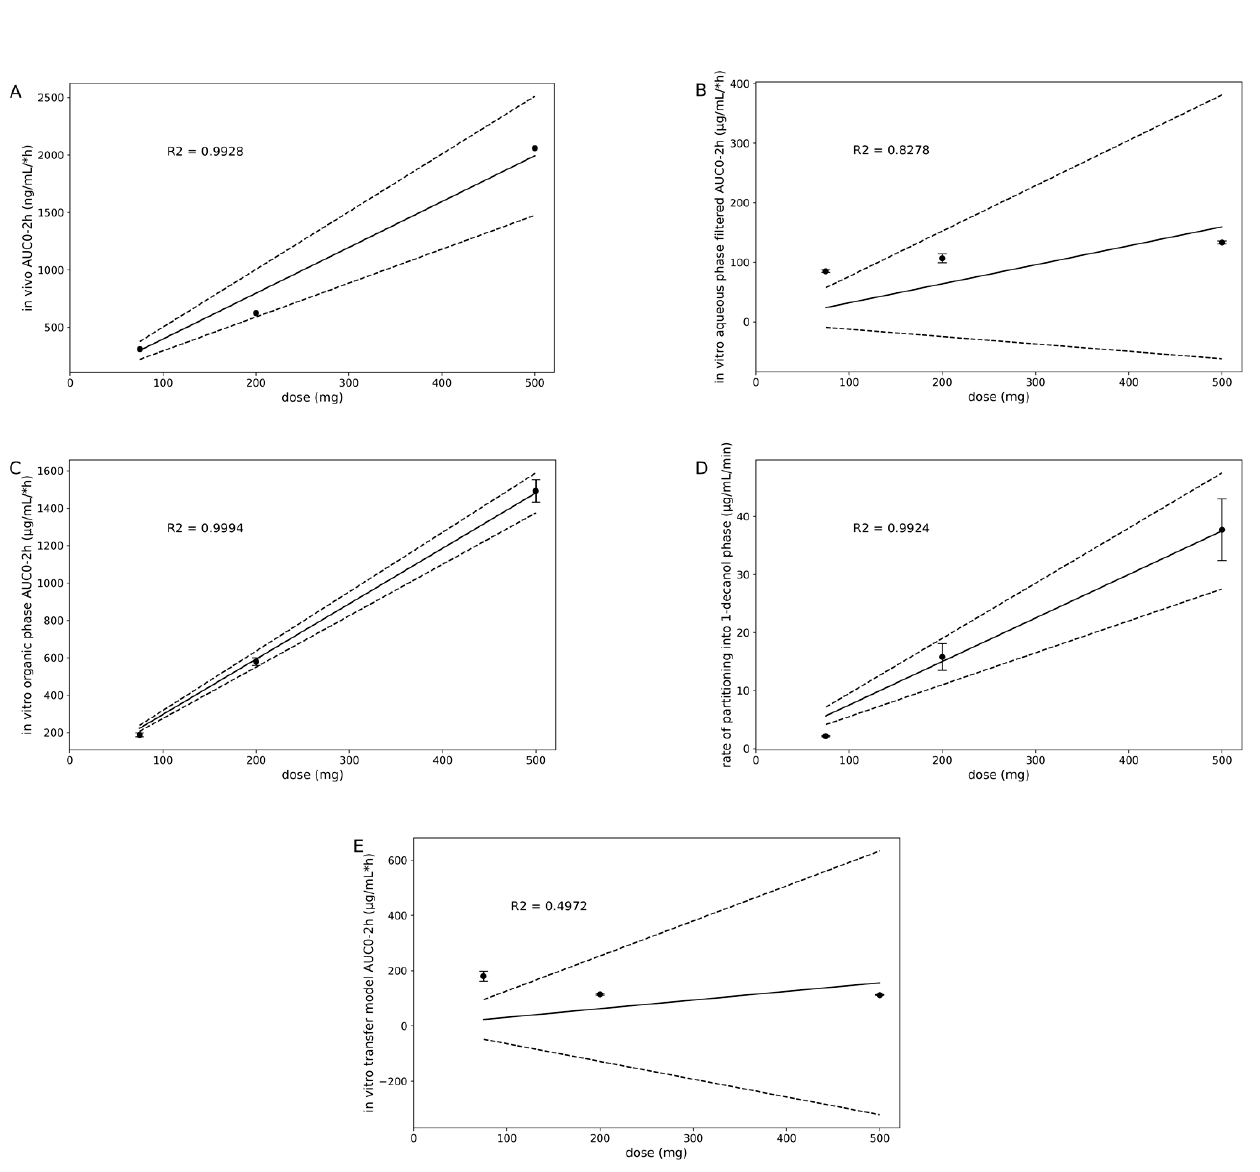
curve during first 2 h, and rate of linear partitioning into organic phase between 7.5 and 20 min (( D ); slope = 0.075; p = 0.0038) during in vitro DTPS experiments using 75, 200, and 500 mg MSC-A as OS.